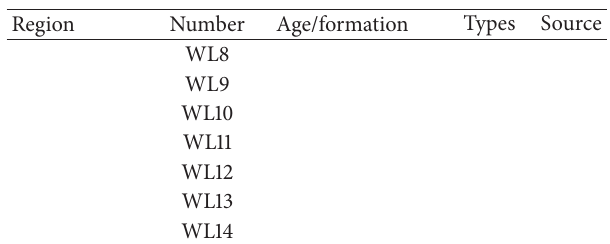
Table 1: Shale samples